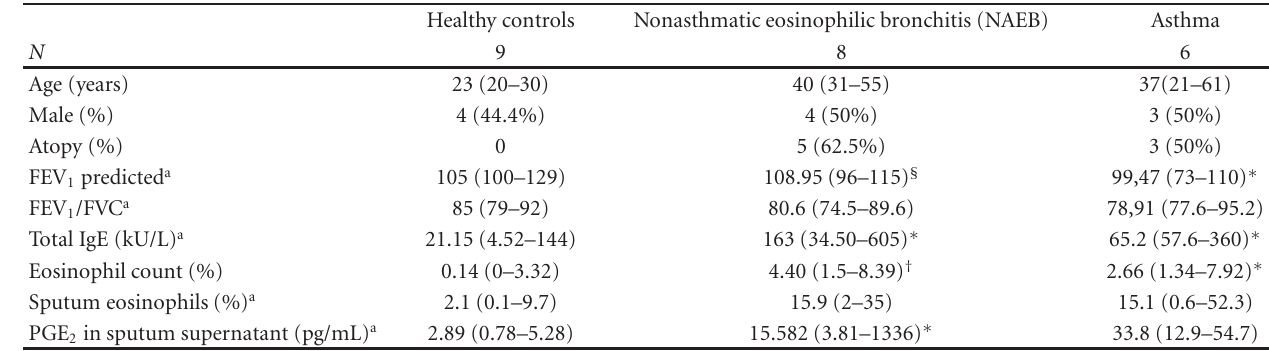
Table 1: Clinical characteristics of study